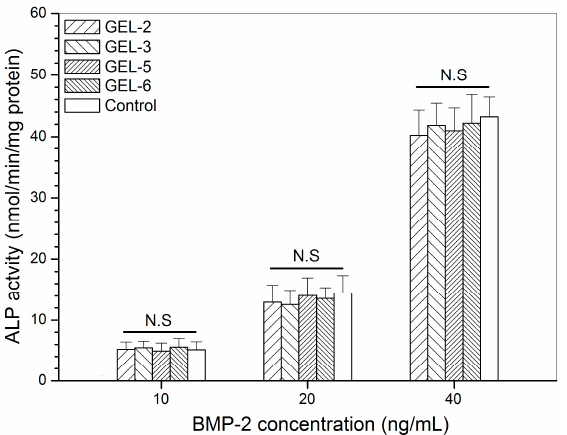
Figure 7. Alkaline phosphatase activity of C2C12 cells that were cultured with BMP-2 released from GEL-3 and GEL-6 gels (see Table 4 for the composition of gels, control: free BMP-2; N.S.: no significance; culture time: 7 days).